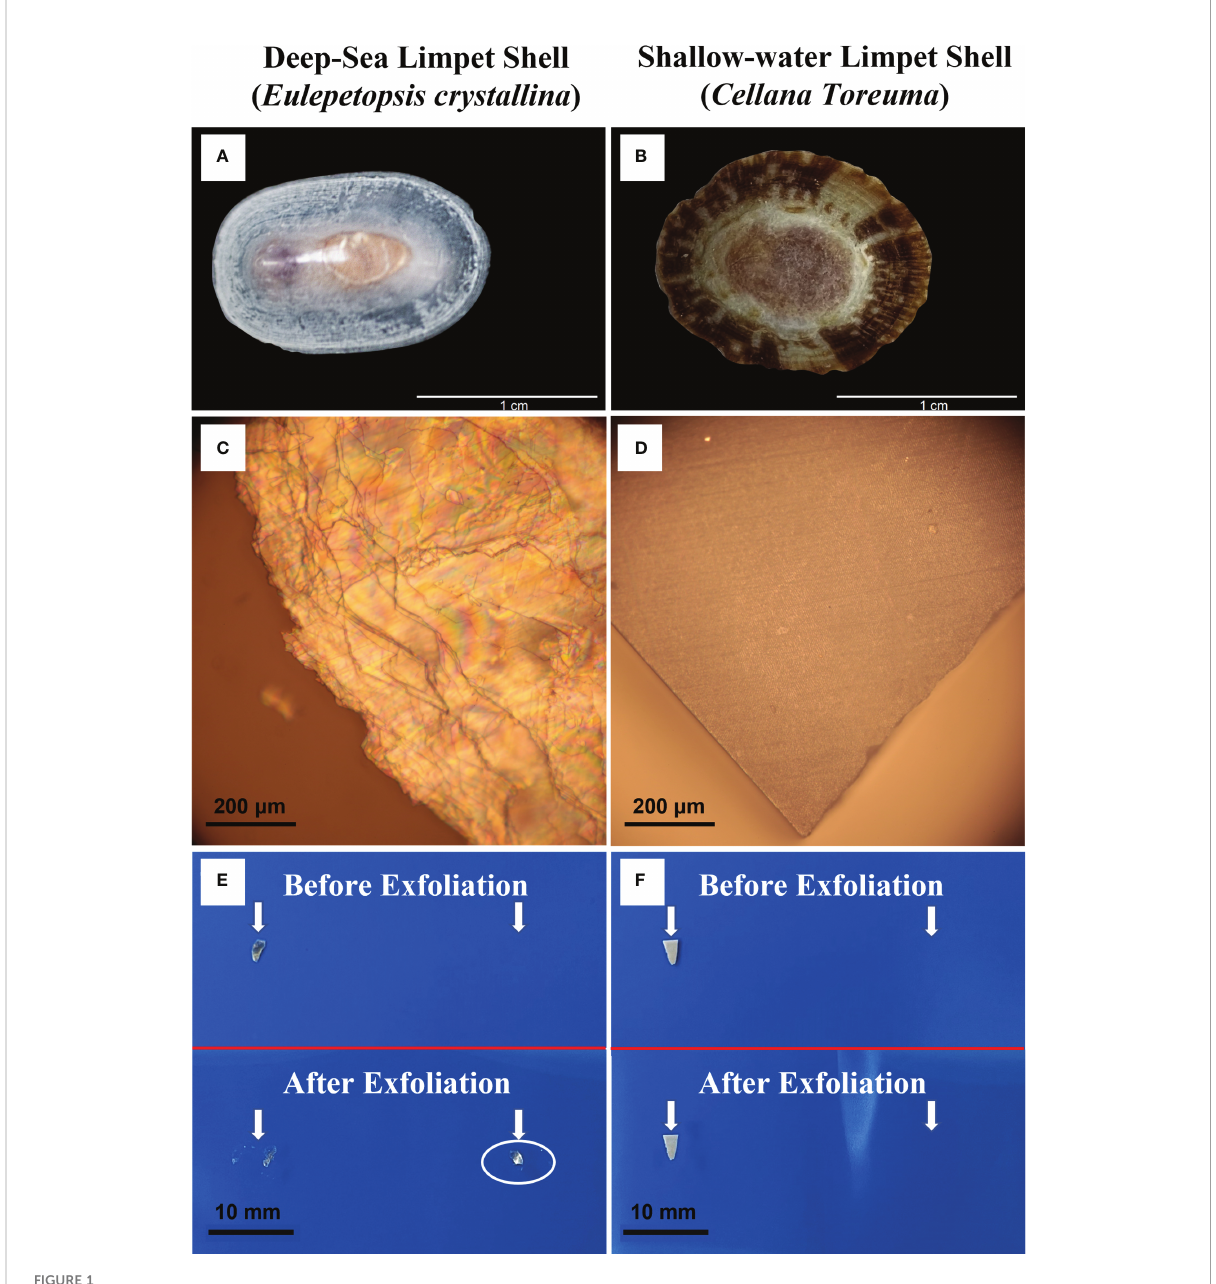
FIGURE 1 Optical images of (A) deep-sea limpet E. crystallina shell; (B) shallow-water limpet C. toreuma shell; (C) E. crystallina shell surface showing evident interference fringes; (D) C. toreuma shell dense and smooth surface; (E) visible exfoliation property of deep-sea limpet E. crystallina shell structure before and after exfoliation, and (F) shallow-water limpet C. toreuma shell structure before and after exfoliation. [Photos Figure 1A courtesy of Dr. Chenggang